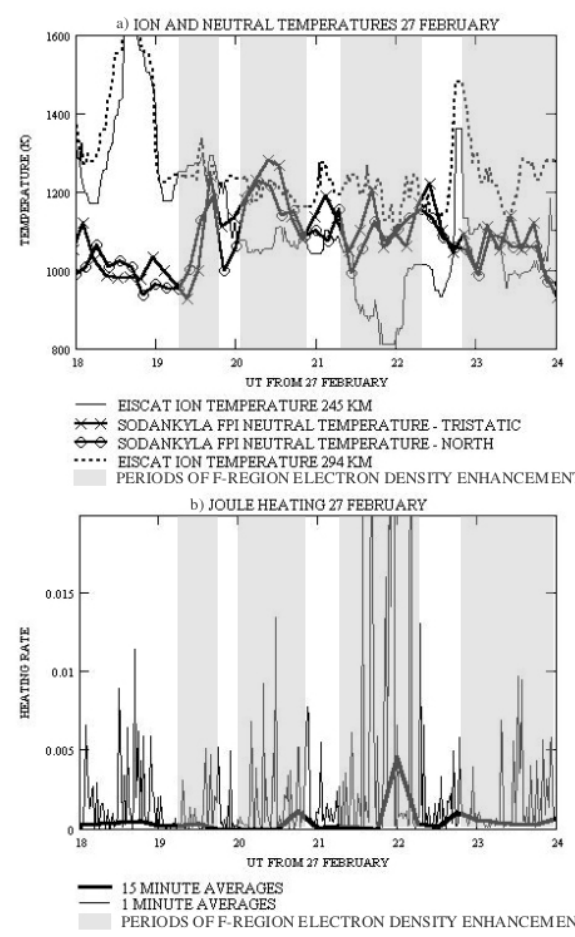
Fig. 7. (a) Comparison of Sodankyl¨a FPI measurements of T n at tristatic A and North look directions with EISCAT T i at altitudes of 245km and 294km for the period 18:00–24:00 UT on the night of 27–28 February 2003. (b) Illustrating the importance of meso-scale ion velocity variability for determining Joule heating by comparing 1-min and 15-min average values for the same period as Fig. 7a. The periods of F-region intensifications of electron density are indicated by grey panels on Figs. 7a and